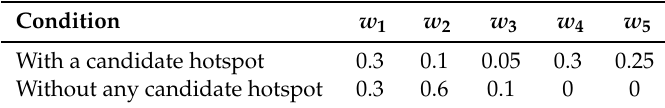
Table 3. The weights were applied in the utility function.